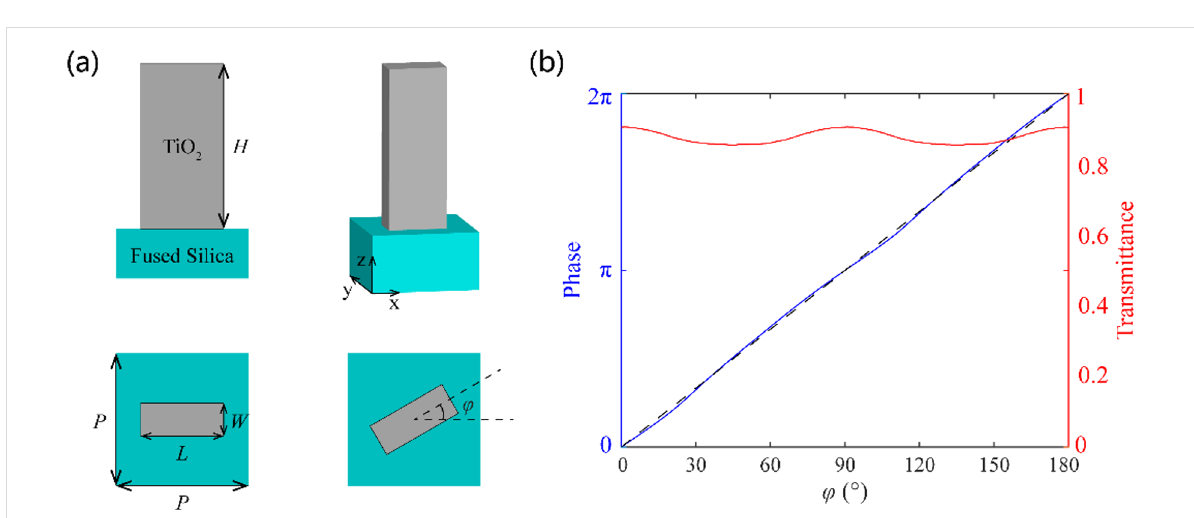
Figure 3: (a) Schematic of a TiO 2 rectangular nanopillar. (b) Simulated transmittance and phase modulations of the unit cells with different orienta- tions. The black dashed line represents the theoretical modulated